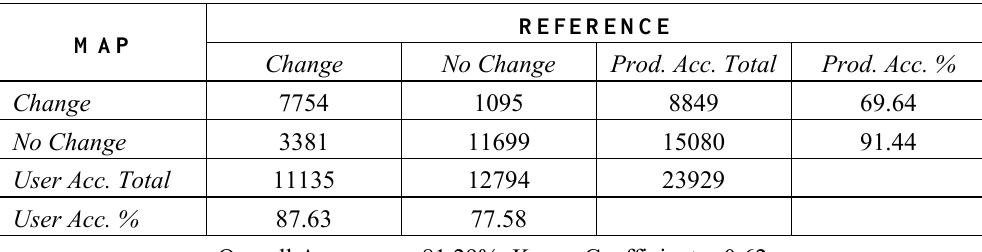
Table 6. Final change/no change